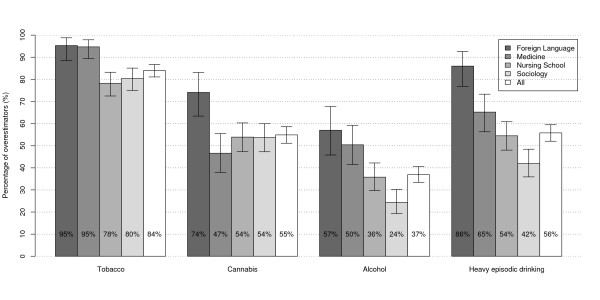
Prevalence of substance use overestimation by academic discipline and 95% confidence intervals. p ≤ 0.001 for the chi-squared test of independence between academic discipline and substance use overestimation for all four behaviours.